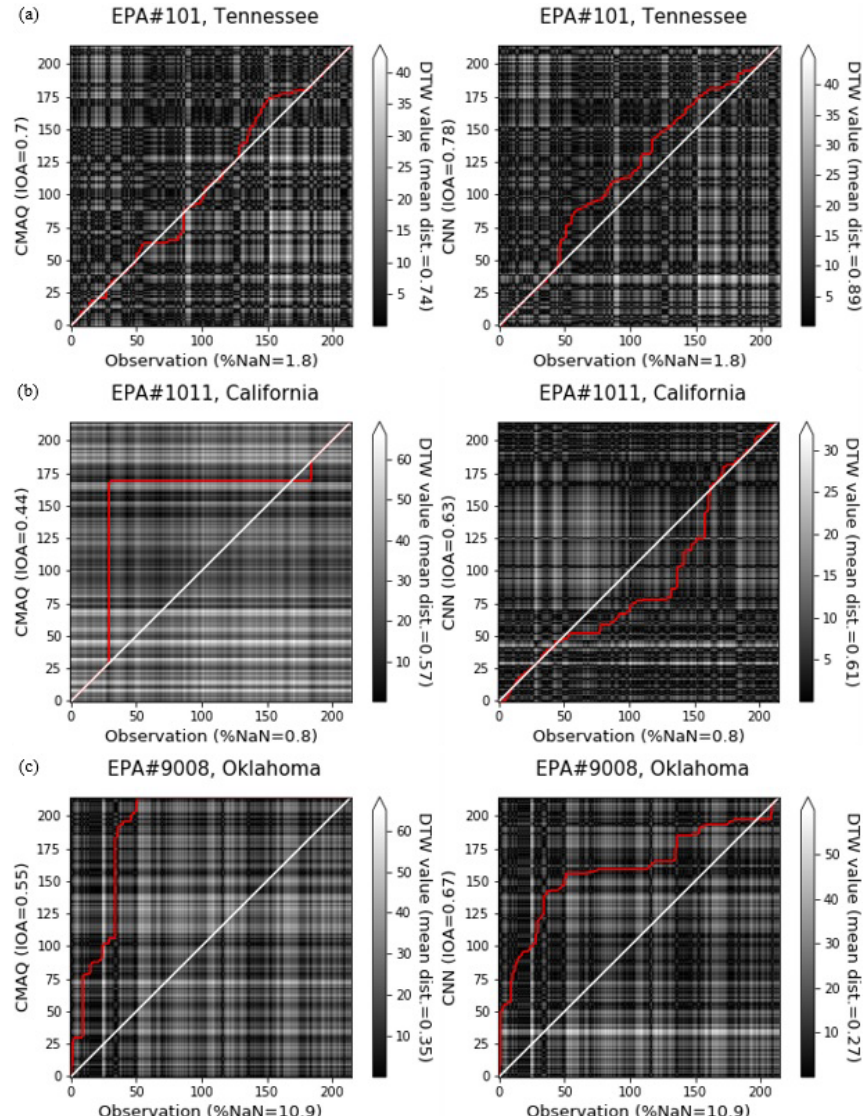
Figure 9. Comparison of the distance analysis of CMAQ and CMAQ-CNN predictions for EPA stations (a) no. 101 (Tennessee), (b) no. 1011 (California), and (c) no. 9008